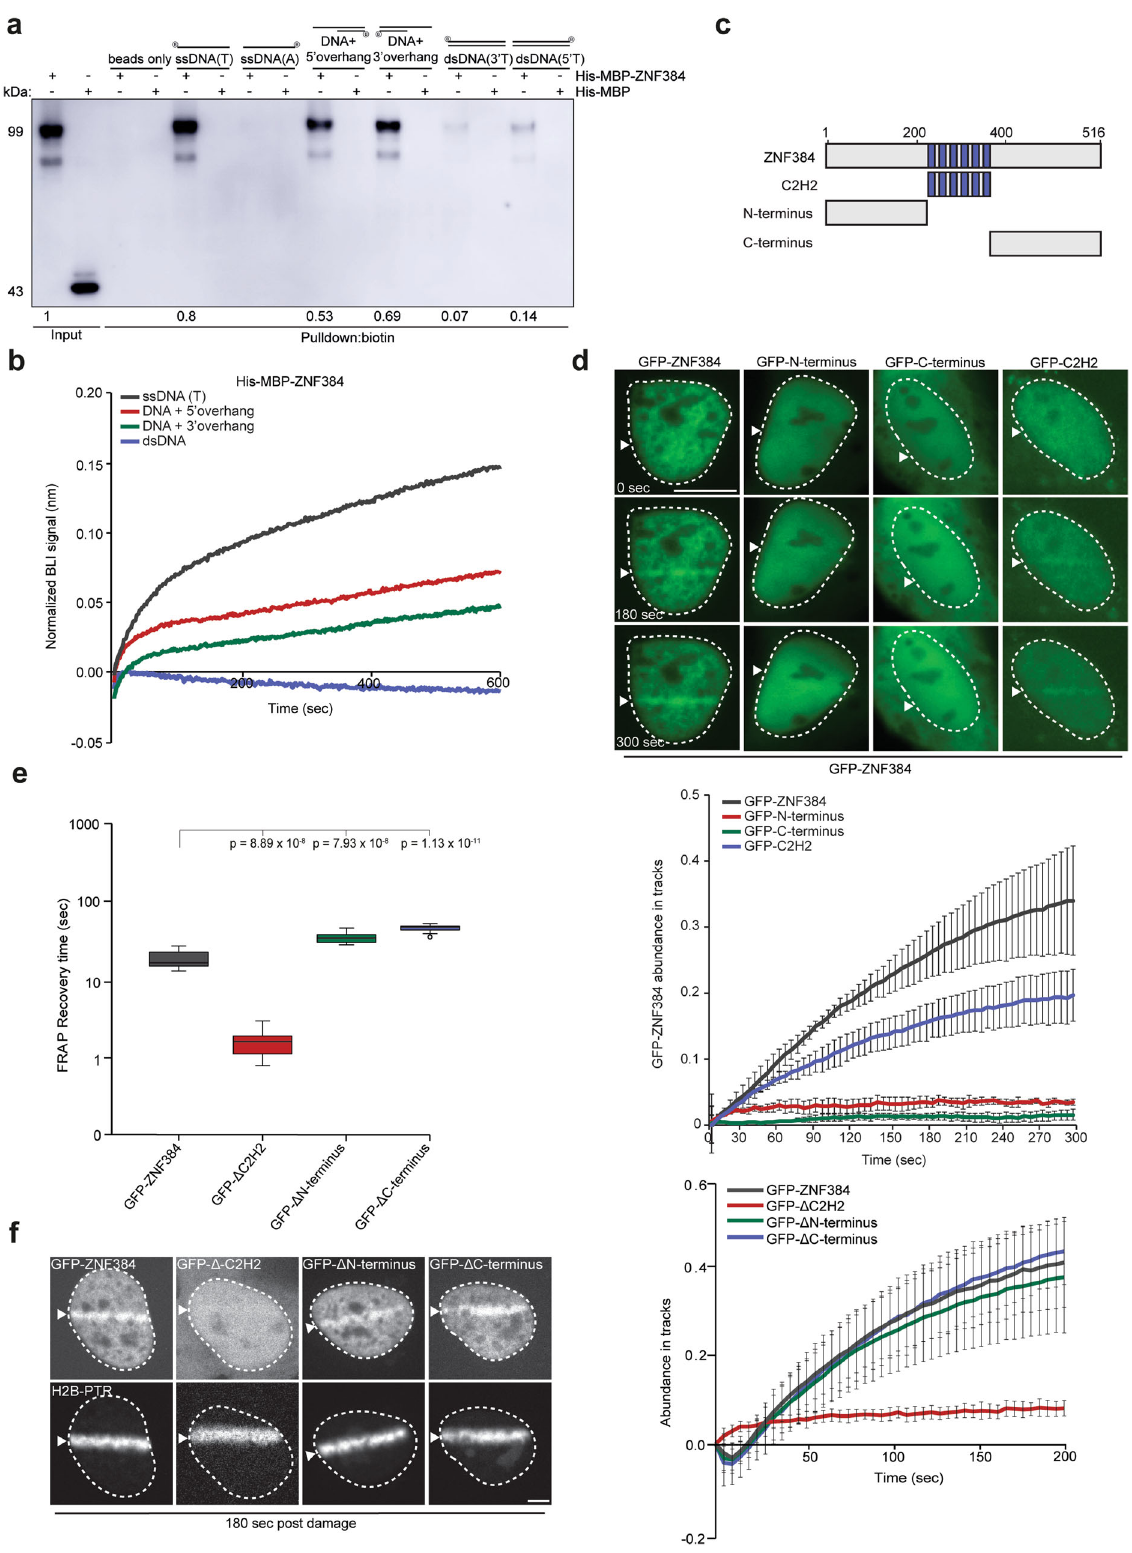
Indeed, we found PARPi treatment to impair the recruitment of Ku70 to DNA breaks (Supplementary Fig. 8F), while the accumulation of the DNA damage marker NBS1 remained unaffected (Supplementary Fig. 8G, H). To better understand the impact of ZNF384 on the dynamics of Ku70, we assessed its turnover at DNA lesions by FRAP. Within 10 seconds